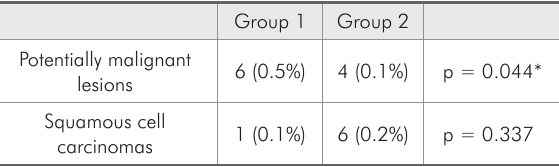
Table 2 - Distribution of potentially malignant lesions and squamous cell carcinomas diagnosed by secondary health care personnel according to